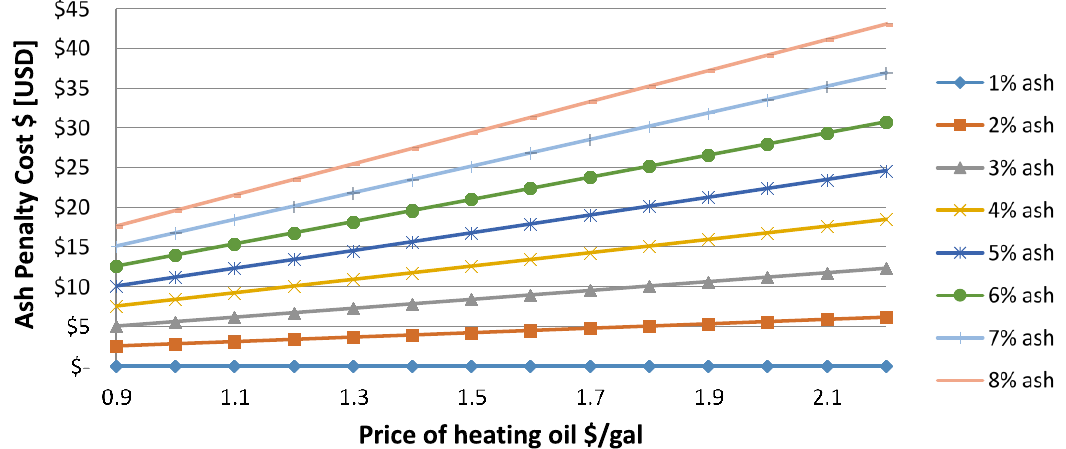
Figure 10. Ash penalty cost (per ton of biomass) obtained from different prices of a gallon of oil and different final ash concentrations.